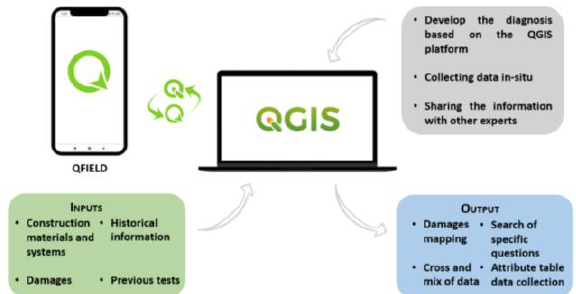
Figure 1. Workflow used during the present work. This is based on the use of the open-source QGIS for managing the information and the app Qfield for acquiring the